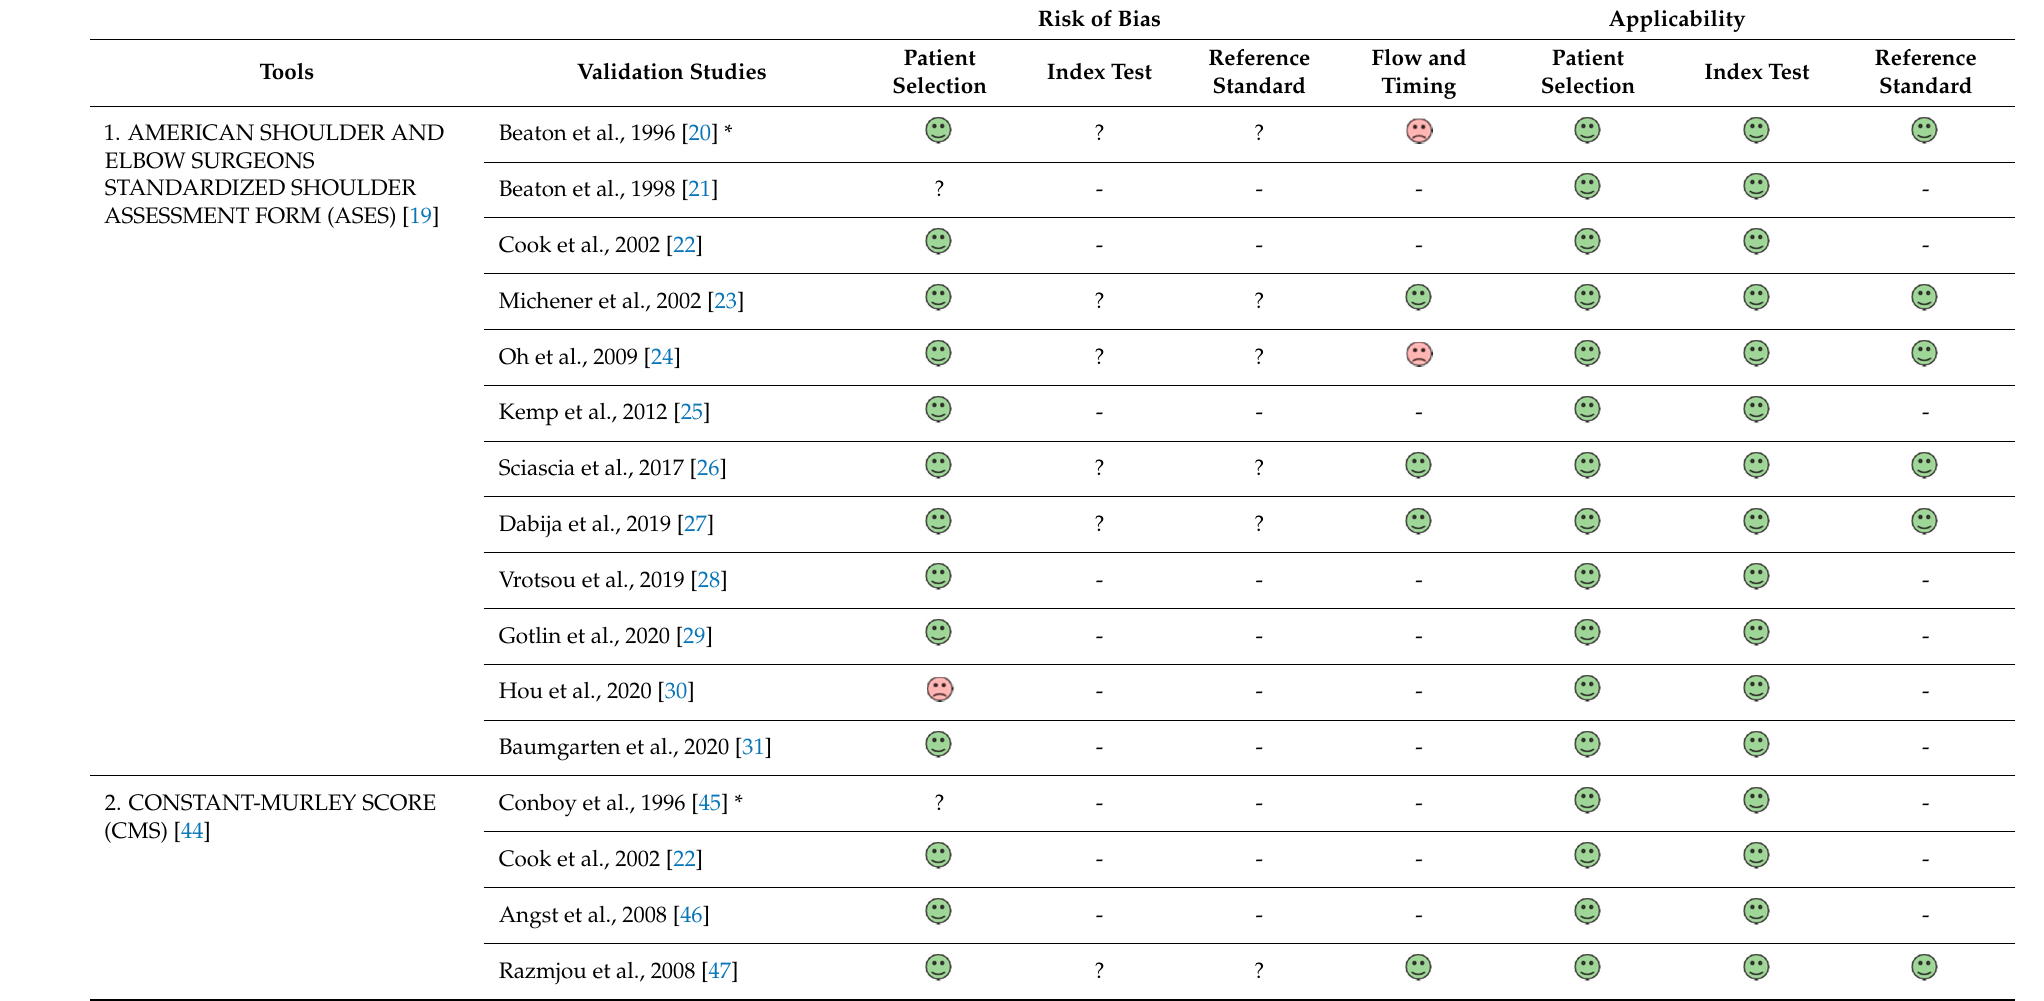
Table 3. Assessment of the methodological quality with QUADAS ‐ 2.